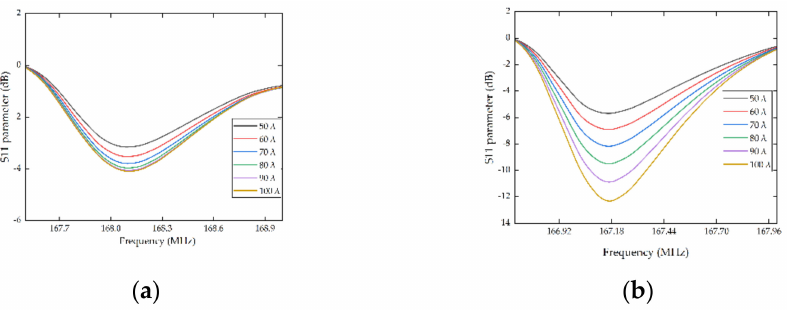
Figure 5. S11 parameter curves of IDTs with different aperture. ( a ) The simulation results with 80 pairs of IDTs, ( b ) the simulation results with 100 pairs of IDTs.